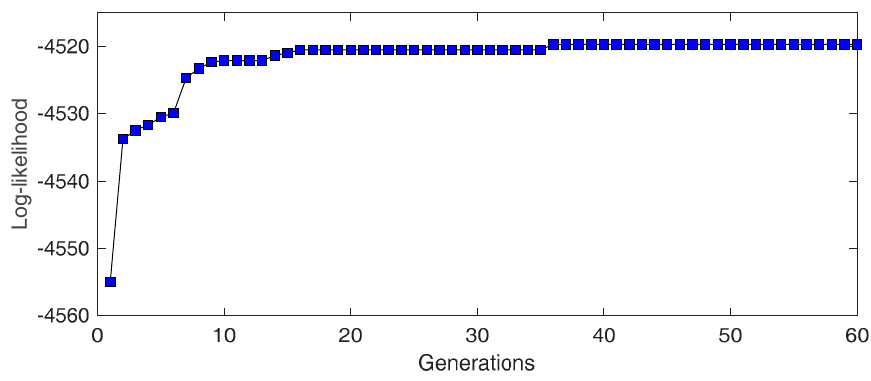
Figure 5. Log-likelihood value of the best individual in the population at successive generations. The values of the best candidate solutions ˆ ϑ opt are reported in Table 4. Maximum likelihood estimation (MLE) estimates of the parameters of the model using differential evolution (DE).